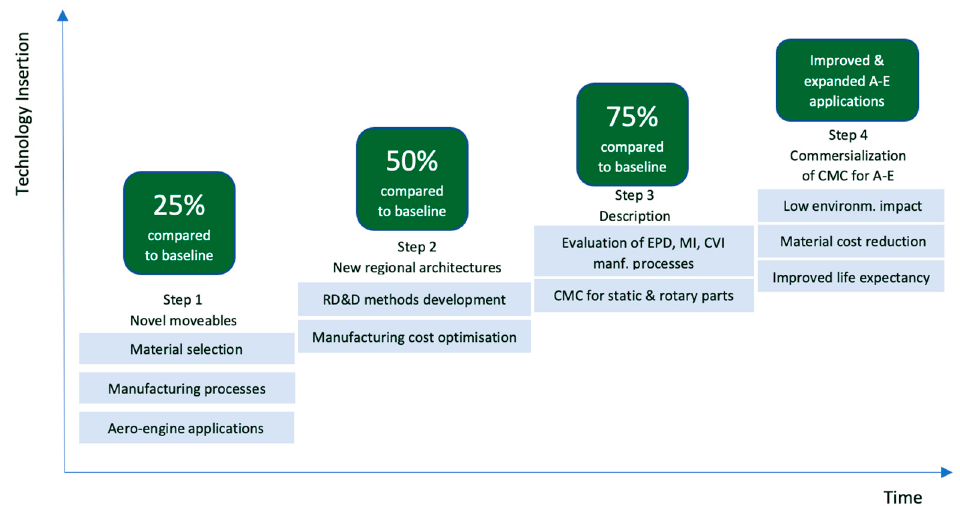
Figure 24. Technology staircase.